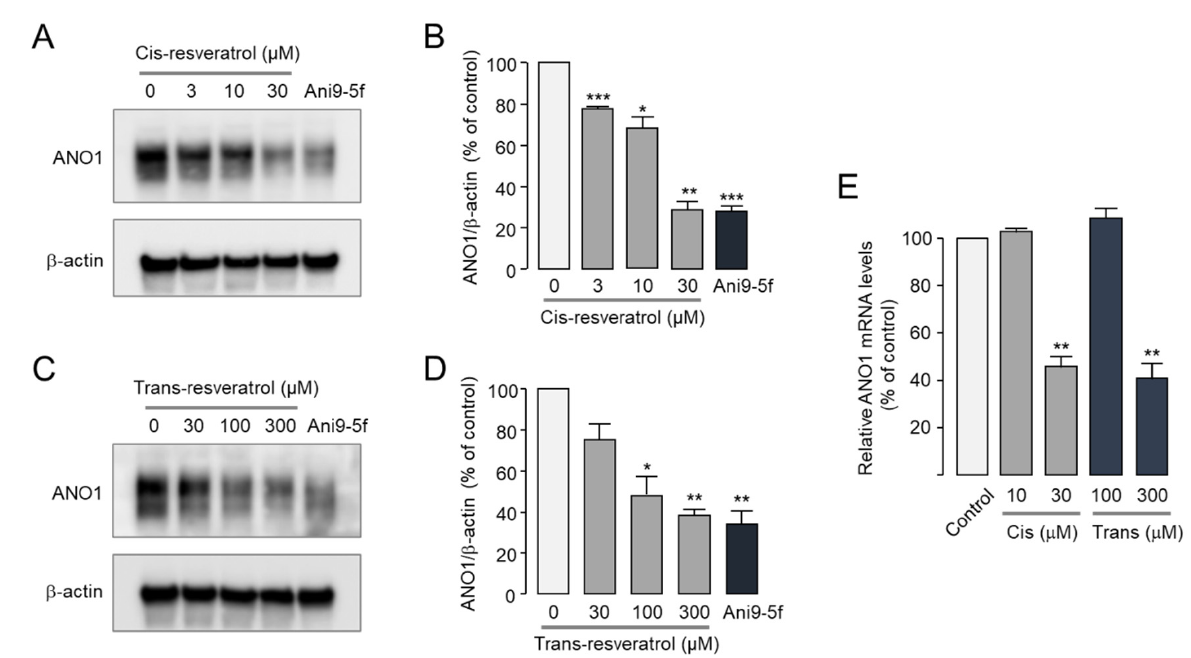
Figure 4. Effects of cis - and trans -resveratrol on ANO1 expression levels in PC-3 cells. ( A – D ) Protein expression levels of ANO1 and β -actin were measured by Western blot analysis. Cells were treated with the indicated concentrations of cis - and trans -resveratrol and 10 μ M Ani9-5f for 24 h. ( B , D ) ANO1 band intensities were normalized to β -actin band intensities (mean ± S.D., n = 3). ( E ) mRNA expression levels of ANO1 were measured by real-time PCR after cells were treated with the indicated concentrations of cis - and trans -resveratrol for 24 h (mean ± S.D., n = 3). * p < 0.05, ** p < 0.01, *** p < 0.001 vs control.